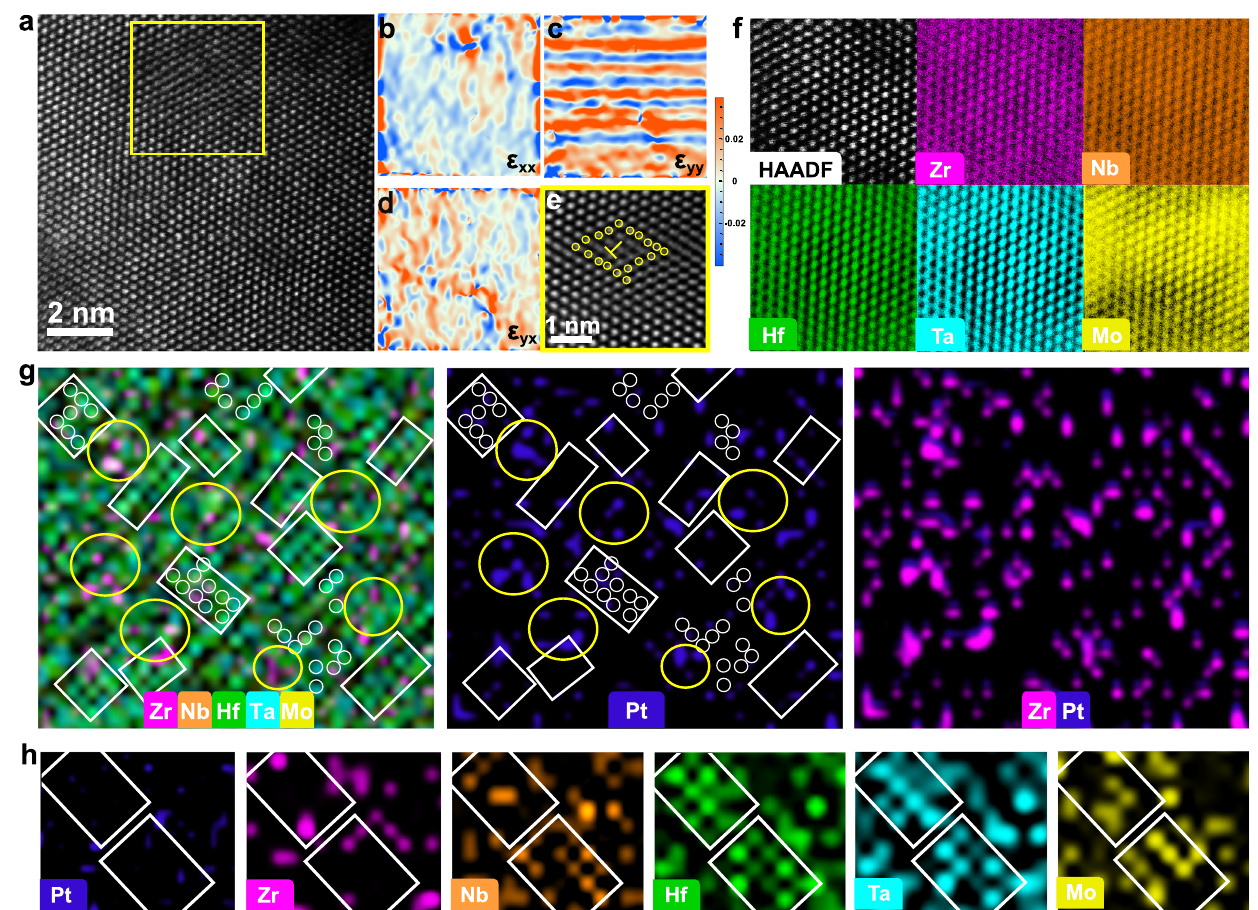
Fig. 2 | Aberration-corrected TEM imaging and mapping of element distribu- tions in the Zr 16 Nb 14 Hf 22 Ta 23 Mo 25 and Zr 15 Nb 14 Hf 22 Ta 22 Mo 24 Pt 3 HEAs, respec- tively. a – d Atomic-resolution HAADF image of Zr 16 Nb 14 Hf 22 Ta 23 Mo 25 HEA and the correspondingatomicstrainmapsofhorizontalnormalstrain( ε xx ),verticalnormal strain ( ε yy ) and shear strain ( ε yx ), suggesting the severe lattice distortion. e The inverse FFT (IFFT) image, corresponding to the area of the yellow square in ( a ) suggests the Burgers circuit encircling the dislocation (marked as “ ⊥ ” , the atoms involvedaremarkedwithyellowcircles). f HAADFimage oftheatomicstructureof Zr 16 Nb 14 Hf 22 Ta 23 Mo 25 HEA, taken with the ½ (cid:1) 111 (cid:2) zone axis, and the EDS maps for individual elements of Zr, Nb, Hf, Ta and Mo, manifesting the relatively